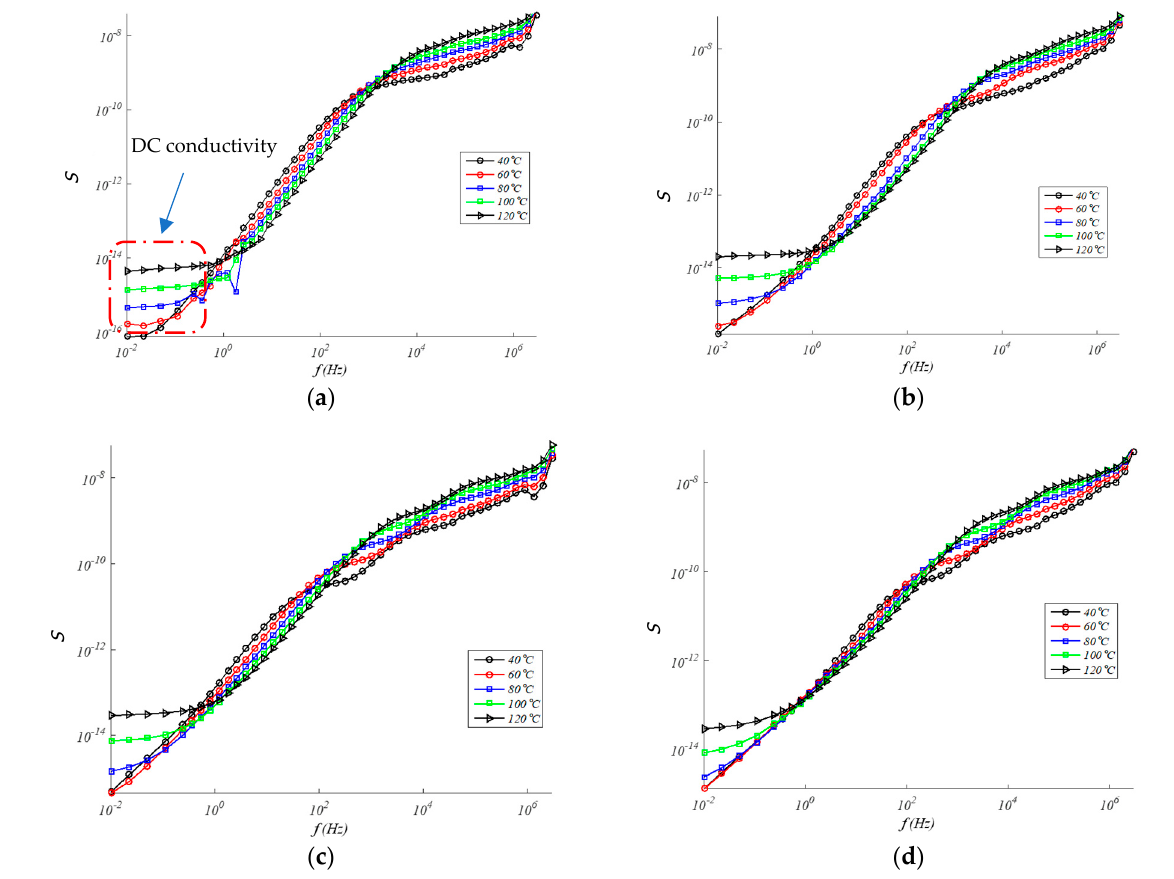
Figure 6. S-Conductivity (S/cm) in EPDM composites for: ( a ) 0% GTR or neat EPDM; ( b ) EPDM + 5% GTR; ( c ) EPDM + 10% GTR; ( d ) EPDM + 20% GTR.